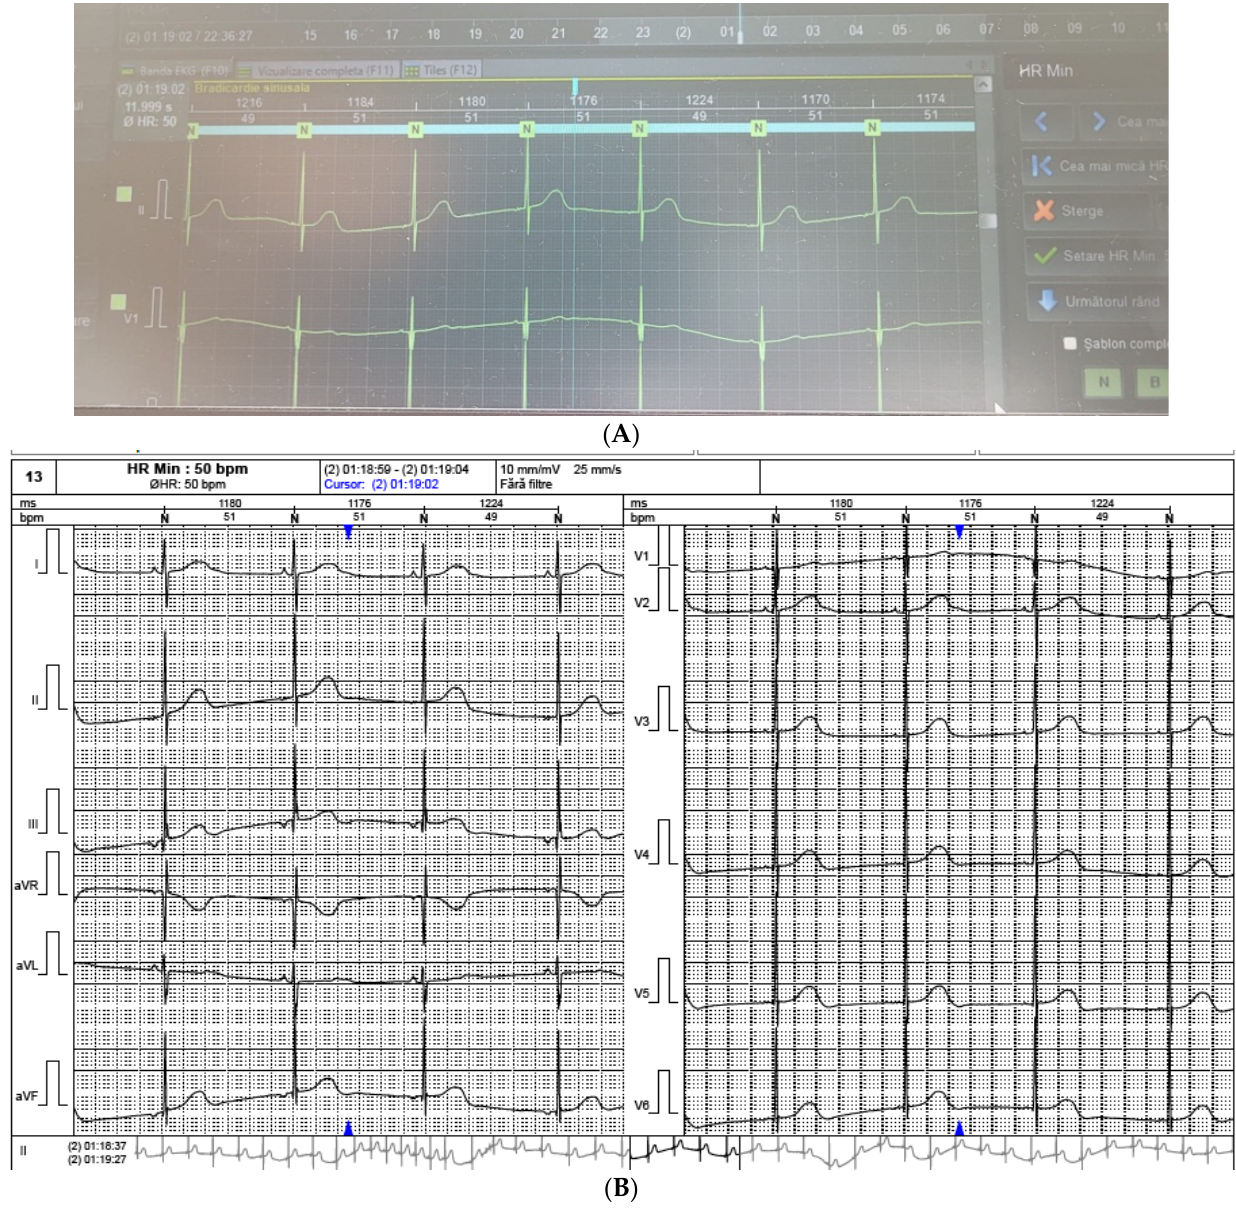
Figure 2. ( A , B ). Severe sinus bradycardia during sleep. Minimum heart rate = 49